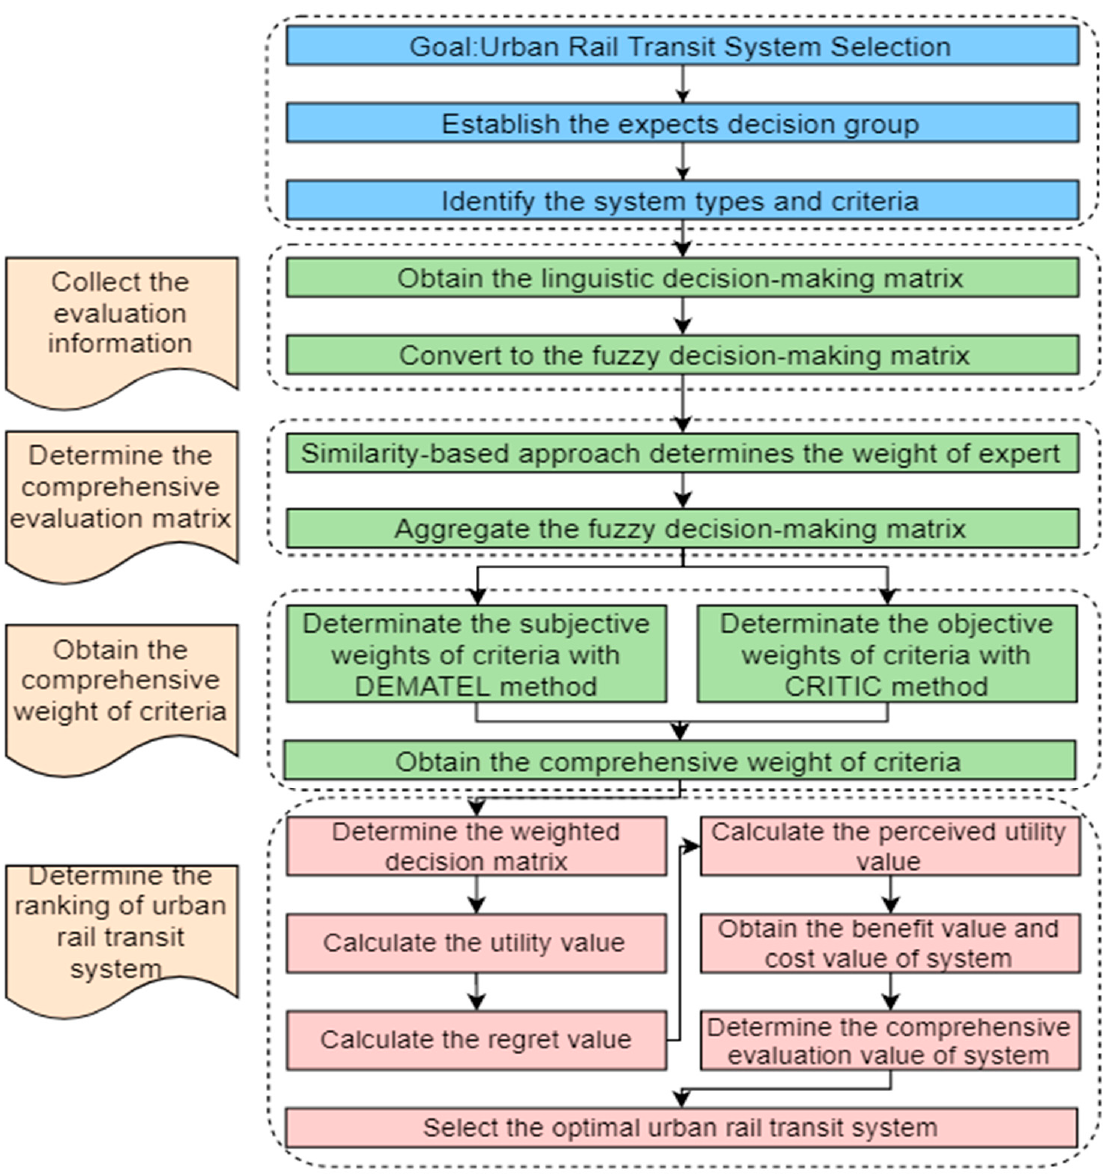
Figure 1. The framework of the proposed method.